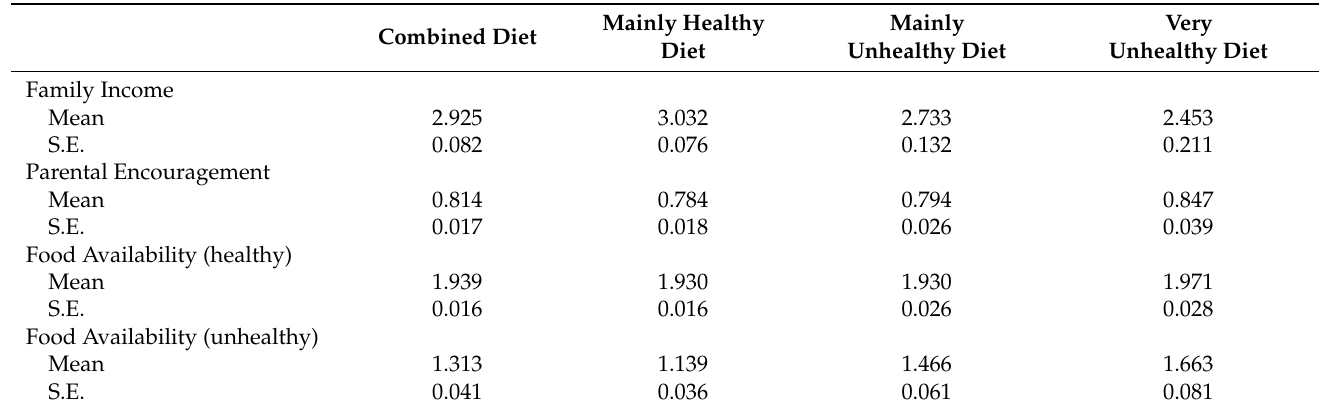
Table 4. Means and standard errors.